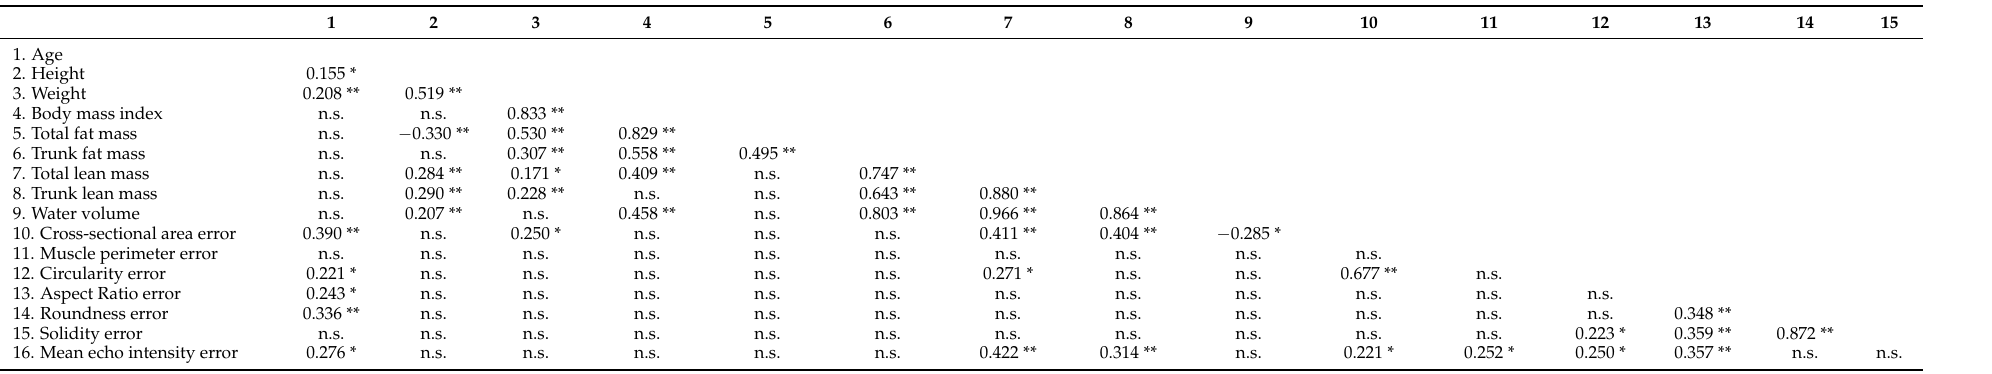
Table 3. Pearson-product moment correlation